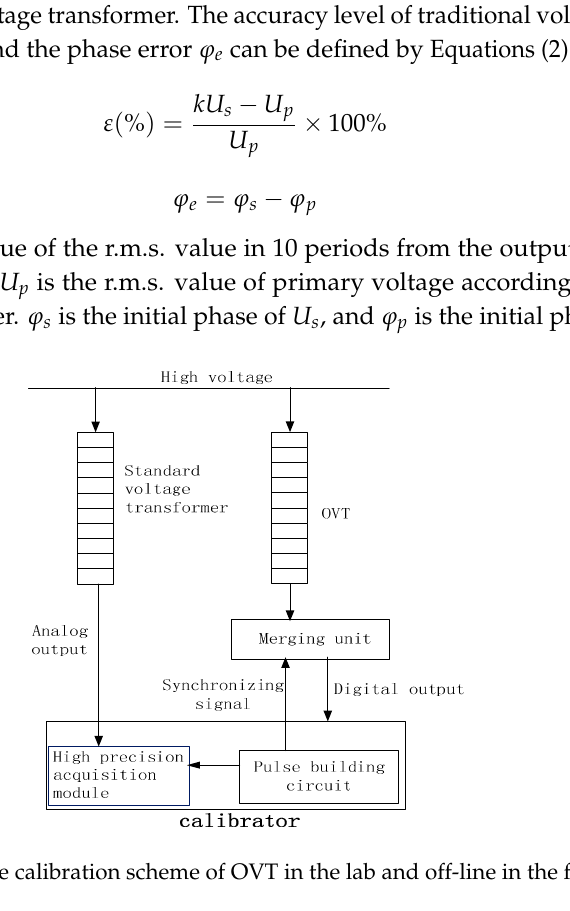
Figure 7. OVT on-line error monitoring system.